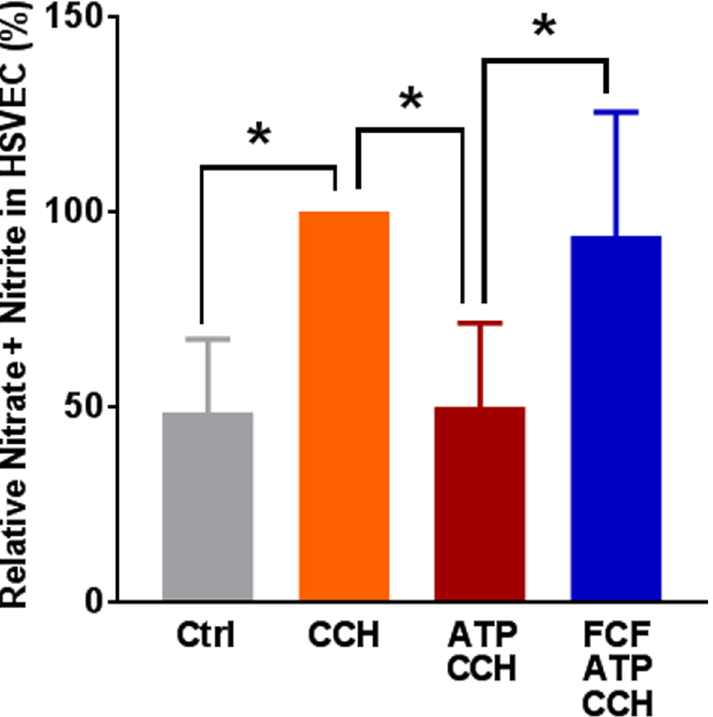
Fig 3. Treatment with eATP reduces nitric oxide production in HSV endothelial cells. HSVEC ( > 70% confluence, passages2–4) were either untreated(Ctrl) or treated with ATP (2 mM) or ATP and FCF (100 μ M) for 2 hours. Cells were stimulatedwith carbachol (1 μ M, CCH) for 10 min at 37˚C, and nitric oxide (NO) generatedby the cells was measured as nitrite. NO generated with CCH was set as 100%, n = 4 passages, * p < 0.05, (One way